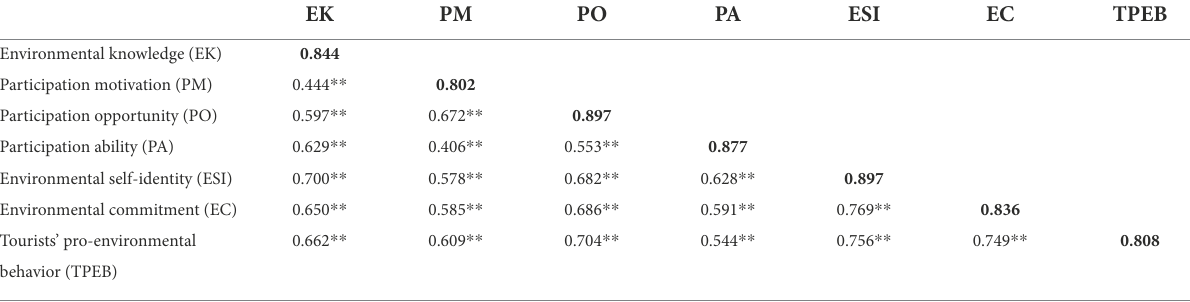
TABLE 3 Fornell-Larcker discriminant validity criterion.